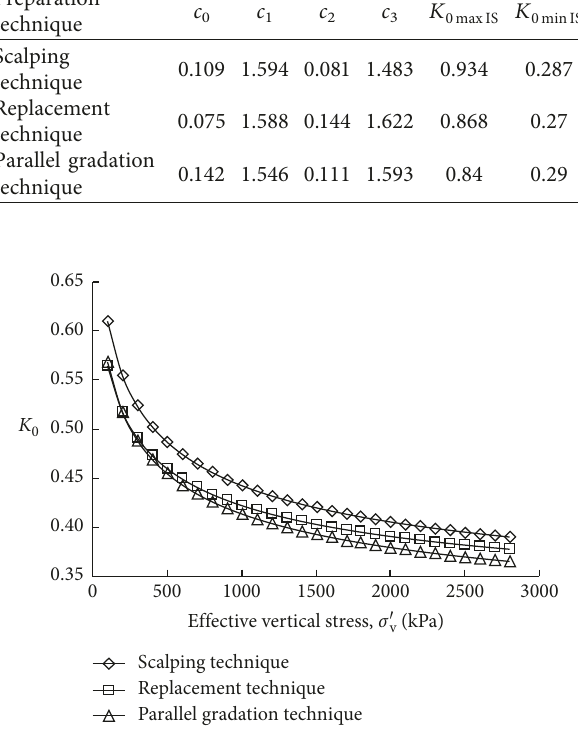
Figure 8: Prediction of K